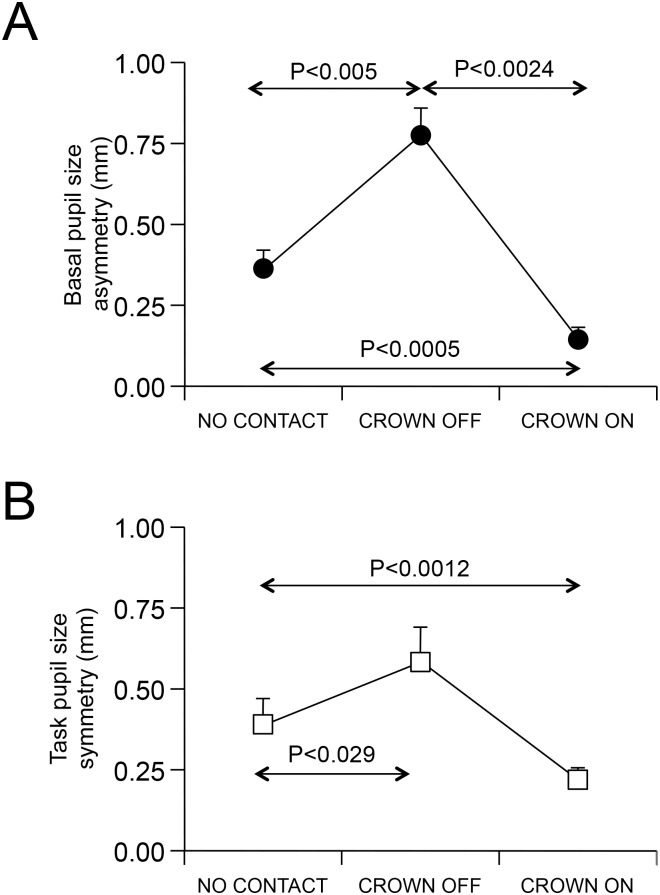
Pupil’s size asymmetries in different conditions.The average difference in pupil size between the larger and the smaller pupil has been displayed for each of the three conditions analysed. A: asymmetries recorded while the subjects were relaxed. B: asymmetries recorded during the performance of the haptic task. In both A and B, the error bars represent standard deviations.